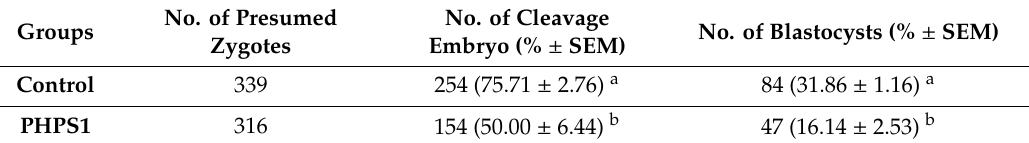
Table 2. Cleavage and development percentage of bovine embryos, Control verses PHPS1 (SHP2